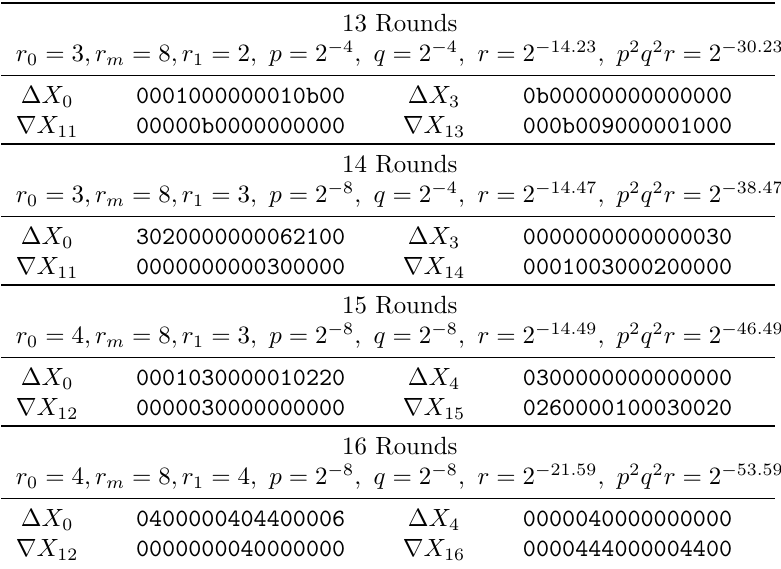
Table 13: Specification of Sandwich Distinguishers for LBlock-s . 13 Rounds